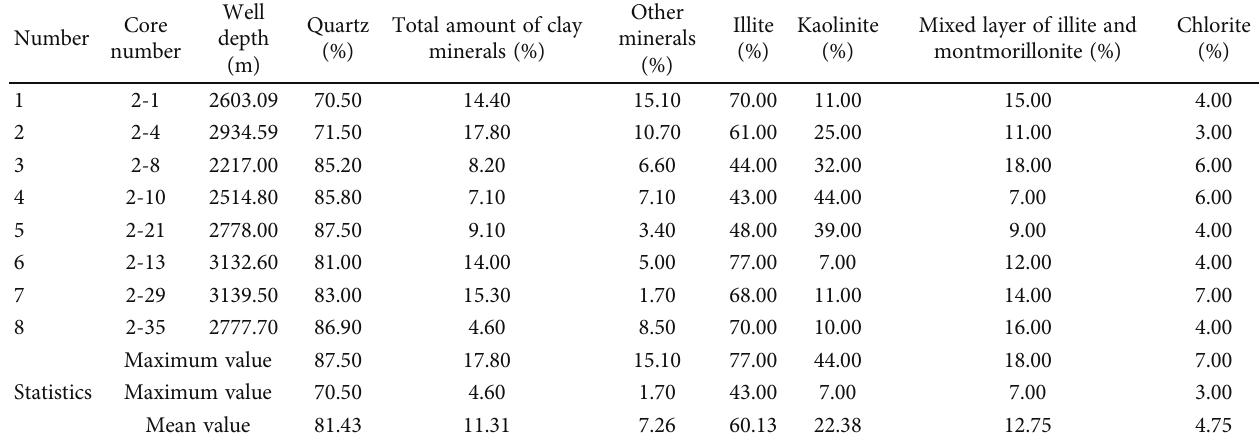
section in Weizhou 11-4 N oil fi eld. 1